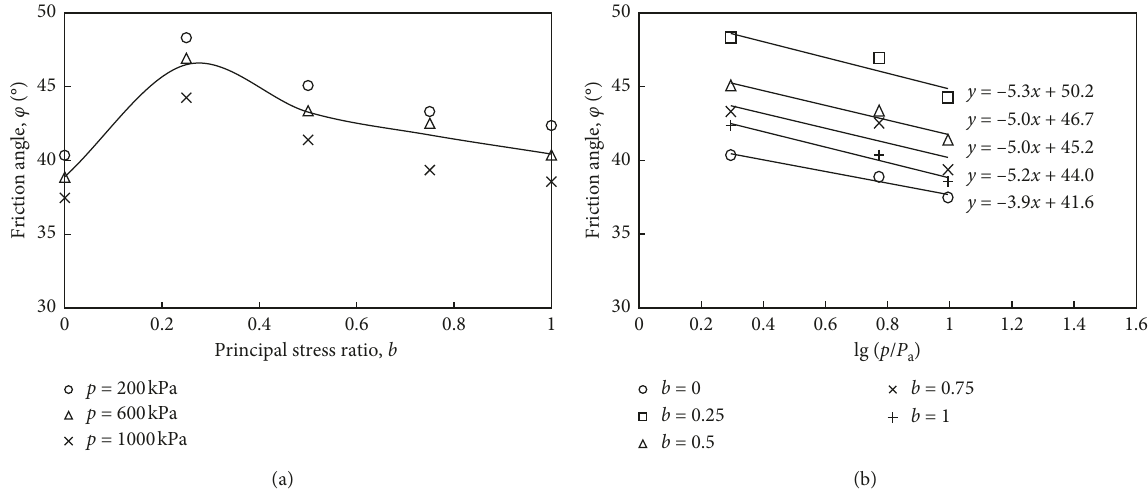
Figure 12: Relation curve between internal friction angle and mean stress for different principal stress ratios: (a) variation of the internal friction angle with intermediate principal stress ratio ( b ); (b) nonlinear variation of the internal friction angle with mean stress ( p ).